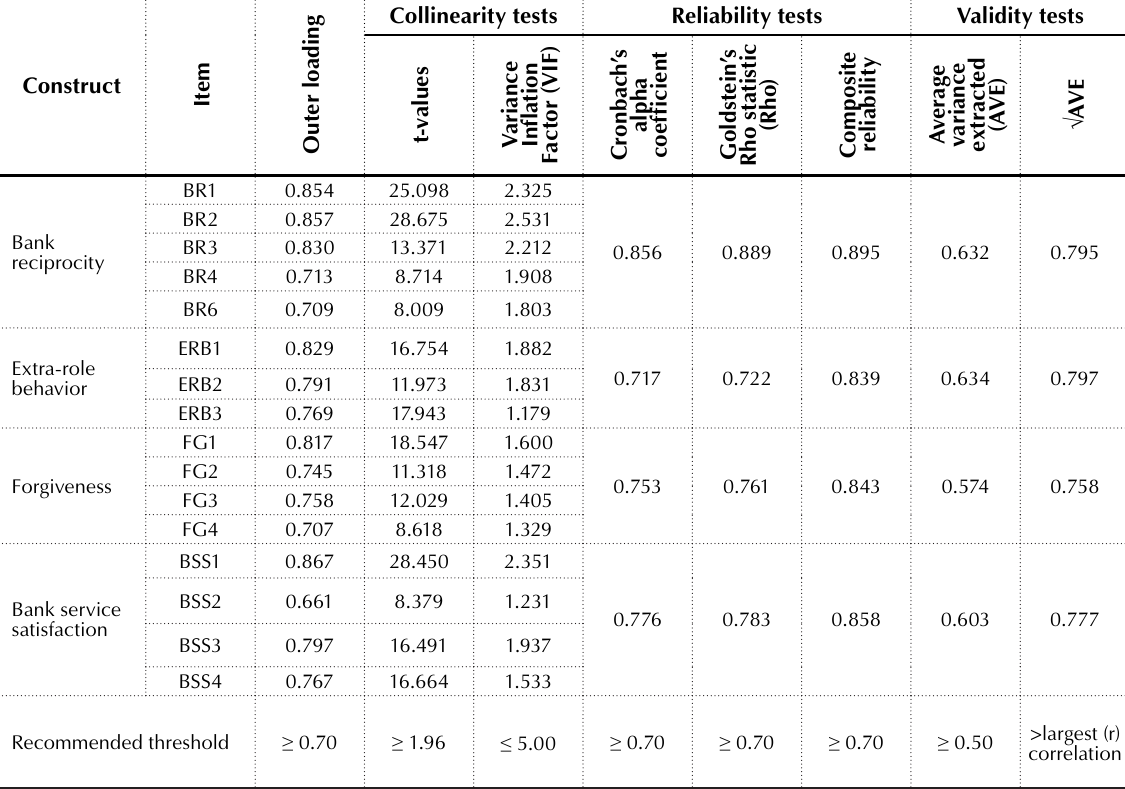
Table 1. Outer model results